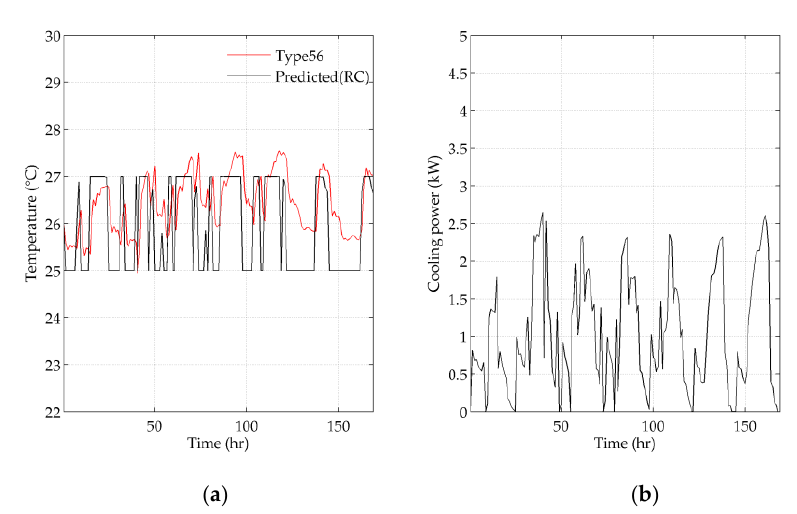
Figure 10. MPC with RC as building prediction model: ( a ) internal air temperature, comparison between the actual Type 56 air zone temperature, and RC prediction at each timestep; ( b ) cooling power profile (control action sequences).